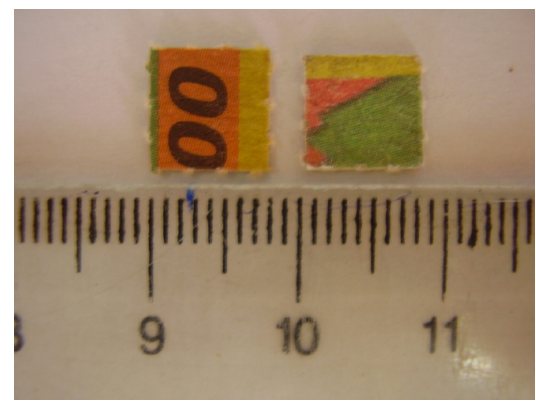
FIGURE 2 - Two samples of blotters seized and analyzed by present